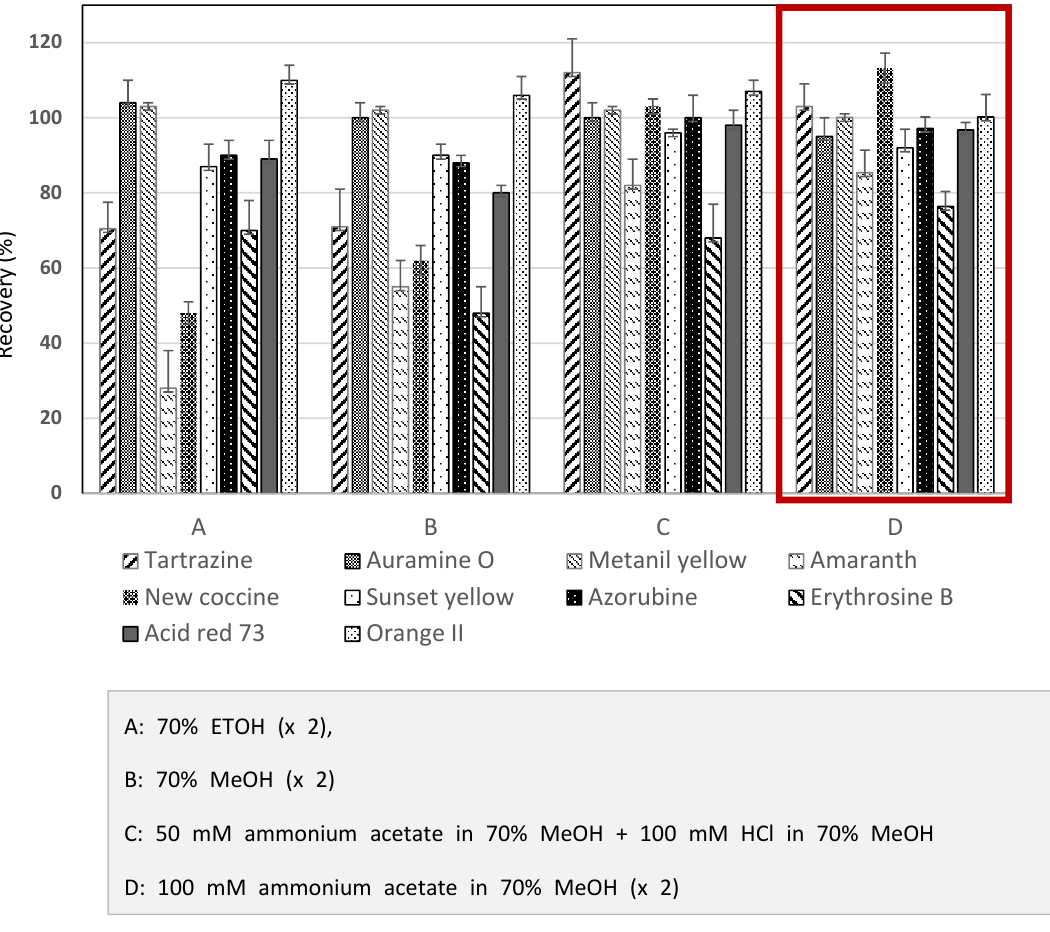
Figure 1. Recoveries of ten synthetic colorants obtained from extraction using various solvents from Hawthorn fruit spiked with the color mixture solution.